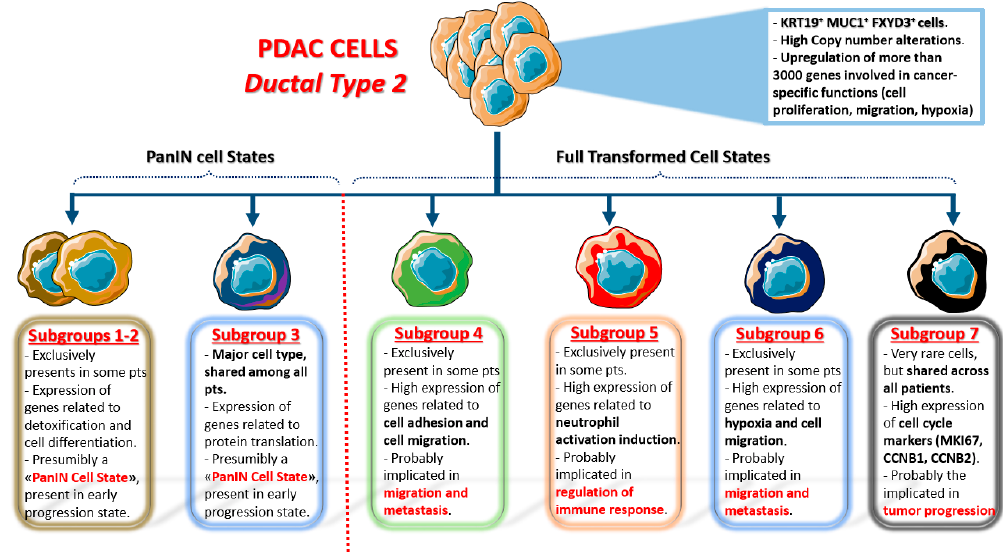
Figure 1. Single cell sub-clusters of malignant ductal cells as emerged by Peng et al. [17]. Created with Servier Medical Art. Servier Medical